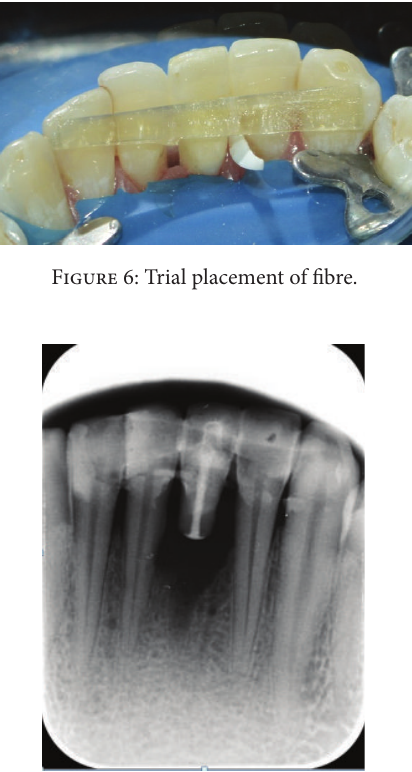
Figure 7: Postoperative radiograph.